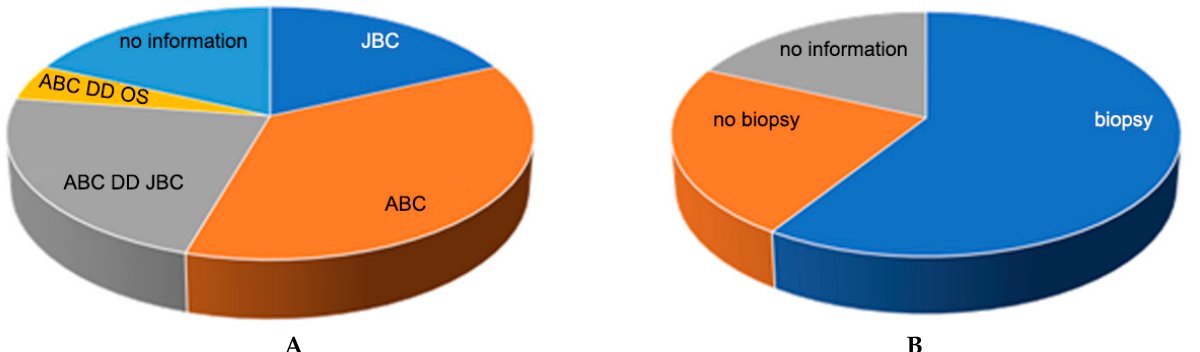
Figure 4. ( A ) Entity assessment: Most participating clinics (n = 22) classified the lesion as an aneurysmal bone cyst (ABC; 36.4%) or considered it in the differential diagnosis (ABC, DD, or juvenile bone cyst [JBC]: 22.7%; ABC, DD, or osteosarcoma (4.5%). Thus, JBC (n = 4) was the next most frequently mentioned differential diagnosis or sole diagnosis. Overall, four responding hospitals did not provide any information on this question. ( B ) Regarding the need for biopsy, of the responding hospitals, 59.1% wanted a biopsy, 22.7% did not consider it necessary, and 18.2% did not provide any information on this.